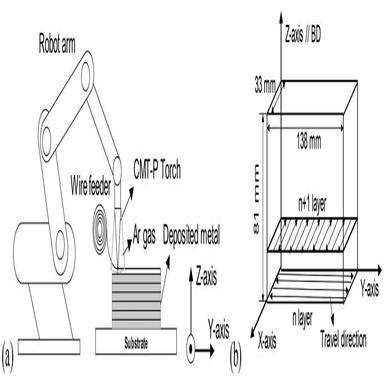
Schematic diagrams of (a) the WAAM fabricated system, and (b) the deposited sample.